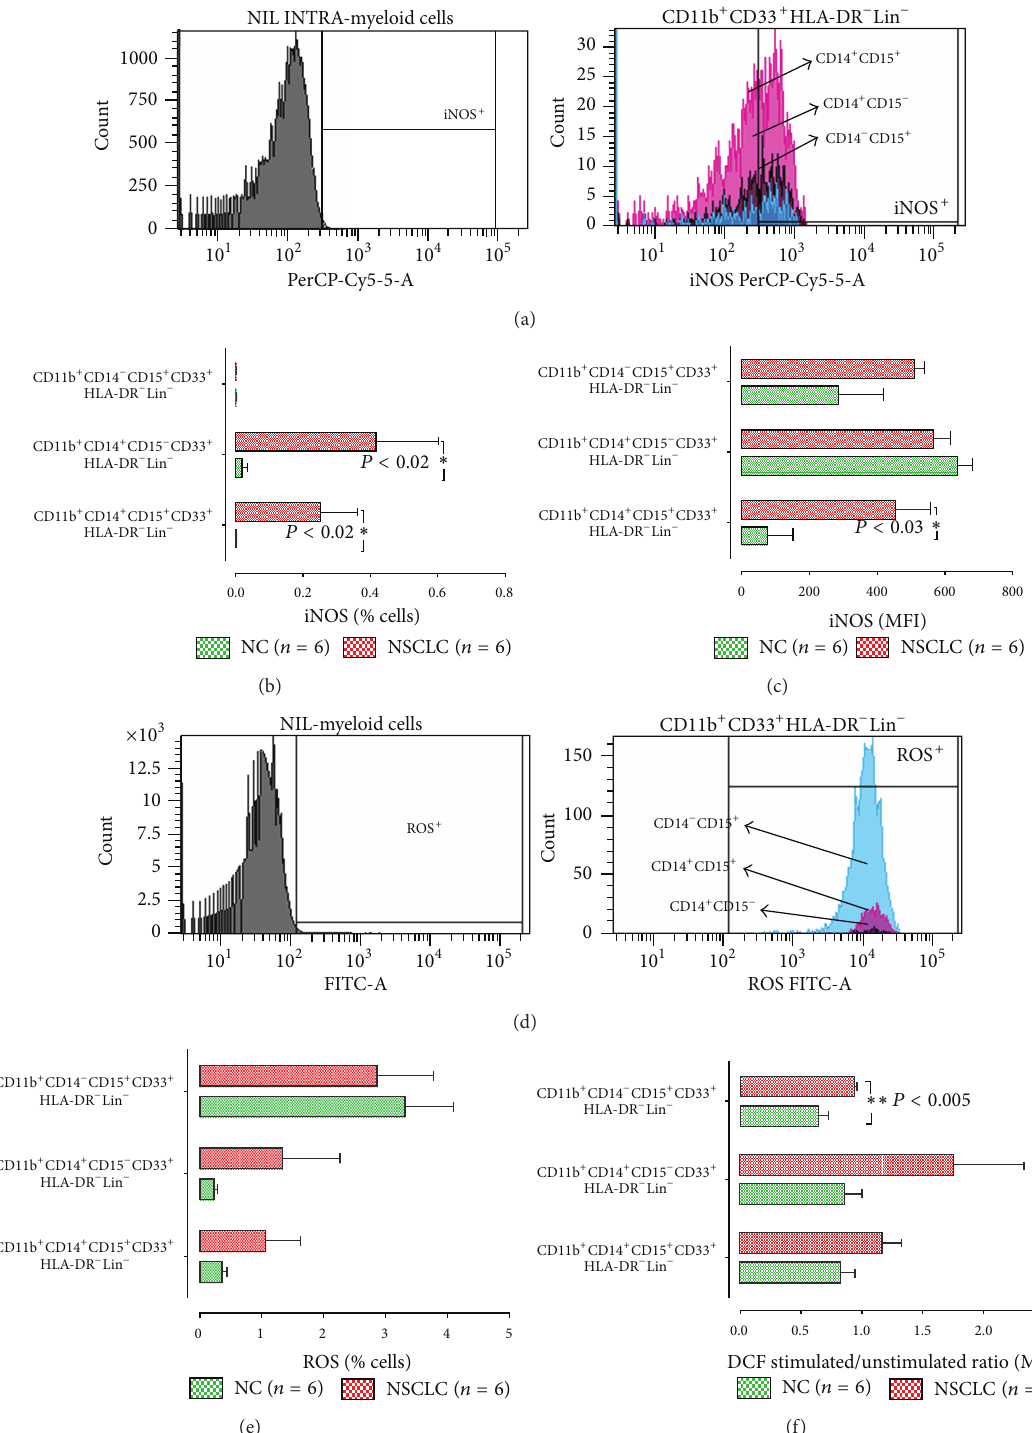
Figure 3: Representative histograms of flow cytometry analysis of (a) iNOS and (d) intracellular oxidative stress by the DCF method. Percentages of (b) iNOS and (e) ROS producing cells from healthy and NSCLC patients. Intracellular levels of (c) iNOS and (f) ROS in all tested subpopulations. The data are the mean fluorescence intensity (MFI). Intracellular ROS levels in subpopulations of MDSCs before and after PMA stimulation. Green bars, healthy controls; red bars, NSCLC patients. The gates for each dot plot and histogram are presented on the top of each box. The positive expression of markers is compared to cells without Ab staining. Colours in histograms represent the differentsubpopulations;pinkcolour,CD11b + CD14 + CD15 + CD33 + HLA-DR − Lin − population;blackcolour,CD11b + CD14 + CD15 − CD33 + HLA- DR − Lin − , and bright blue, CD11b + CD14 − CD15 + CD33 + HLA-DR − Lin − . Percentages indicated in the plots represent the percentages of phenotypic marker expression in the parental population, which are presented inside the brackets. The data are represented as the mean ± SEM and the 𝑃 values are determined by Mann-Whitney